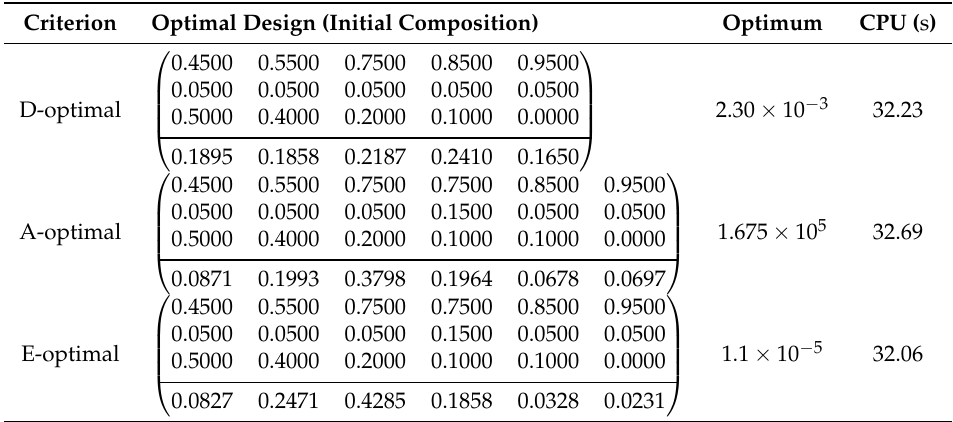
Table 1. Optimal experimental designs for ternary system WAT-TOL-ANL (initial mixtures).